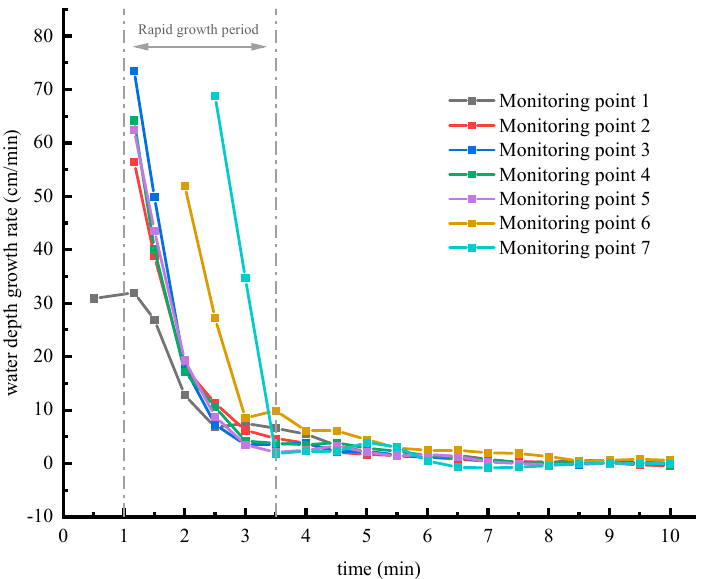
Figure 12. Water depth growth rate at monitoring points on the property development floor as a function of time.